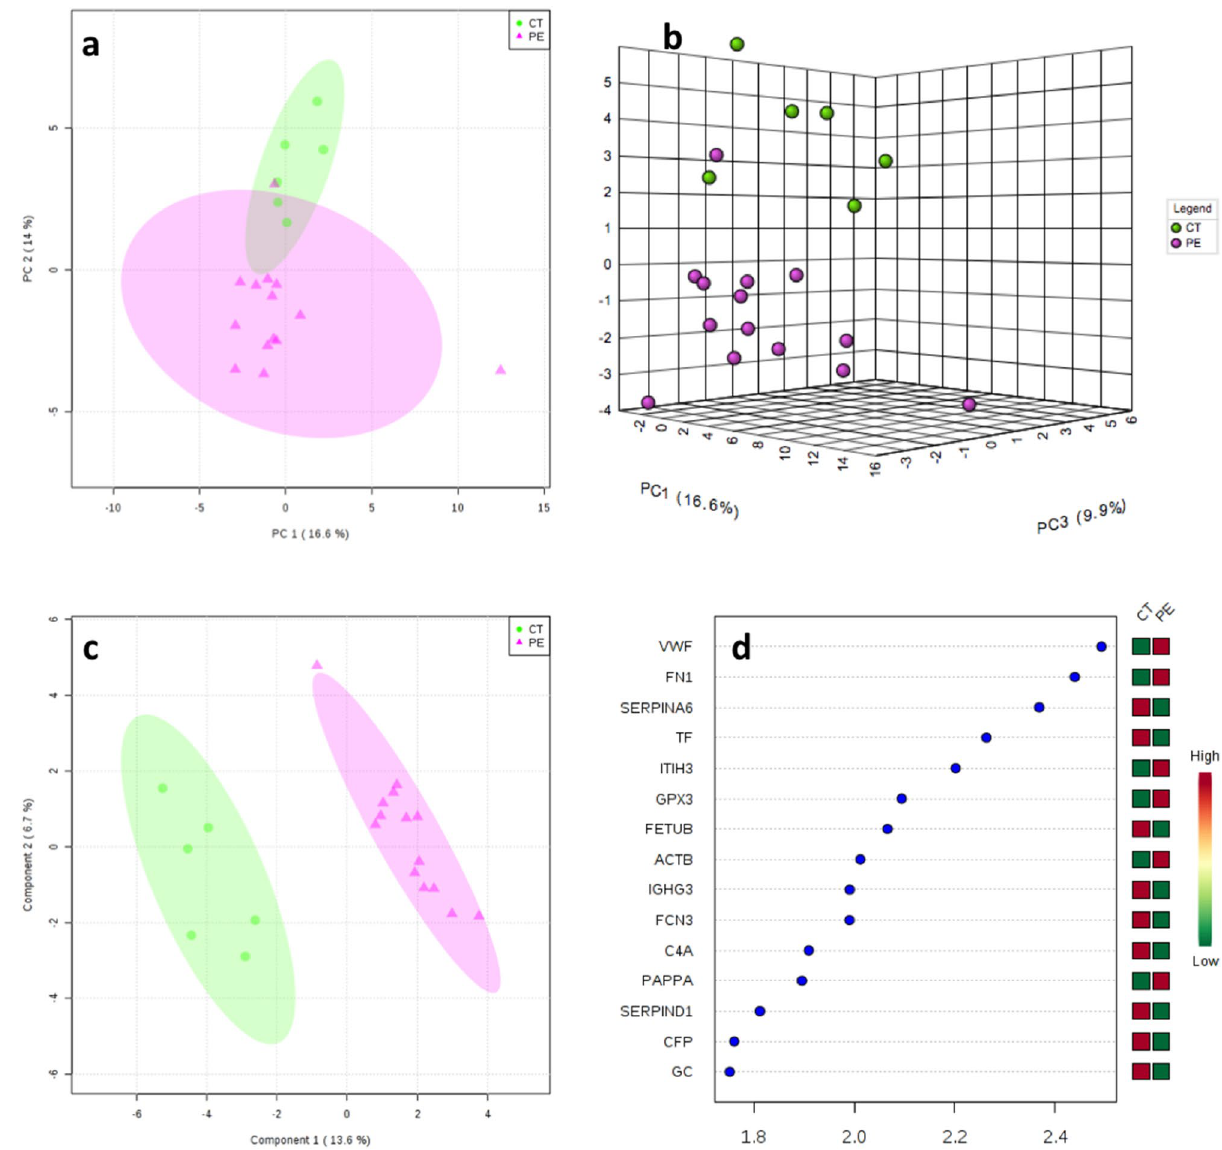
Figure 1. ( a ) 2-dimensional and ( b ) 3-dimensional principal component analysis (PCA) scores plots. ( c ) Partial least squares discriminant analysis (PLS-DA) scores plot between components 1 and 2. The explained variance is shown in brackets. Controls (CT) are presented in green circles and preeclampsia cases (PE) in violet triangles. ( d ) Top 15 most important proteins contributing to groups separation identified through PLS-DA ranked by variable importance in projection (VIP) scores. The right heatmap shows mean intensity variable in the respective group, with red and green indicating high and low protein levels, respectively. VWF Von Willebrand factor, FN1 fibronectin, SERPINA6 corticosteroid-binding globulin, TF serotransferrin, ITIH3 inter-alpha-trypsin inhibitor heavy chain H3, GPX3 glutathione peroxidase 3, FETUB FETUIN-B, ACTB actin, cytoplasmic 1, IGHG3 immunoglobulin heavy constant gamma 3, FCN3 ficolin-3, C4A complement C4-A, PAPPA pappalysin-1, SERPIND1 heparin cofactor 2, CFP properdin, GC vitamin D-binding